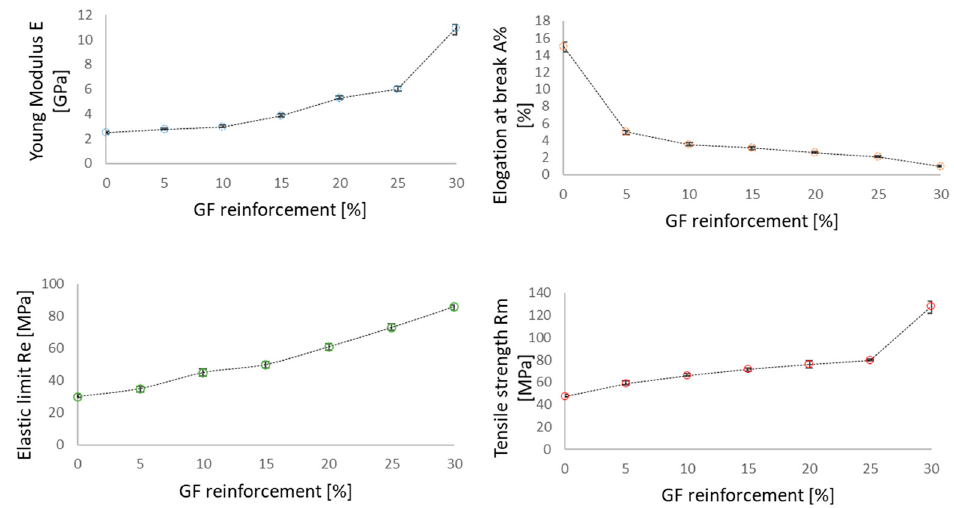
Figure 7. Mechanical characteristics of the composite materials vs. GF reinforcement rate with standard deviation bars.